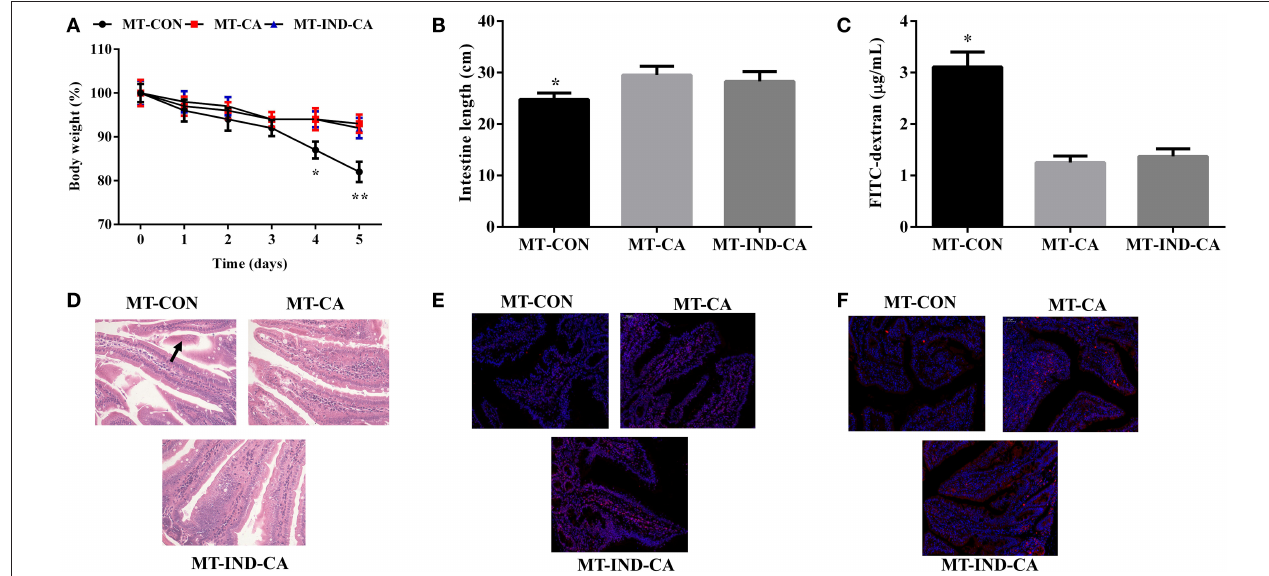
FIGURE 6 | CGA-originated microbiota prevented intestinal morphology damage and barrier dysfunction caused by indomethacin. (A) Body weight changes after the mice were gavaged with indomethacin; (B) intestinal length; (C) Concentration of FITC-dextran in serum; (D) HE staining of colon morphology (200 × ), The morphology changes were marked with black arrows; Occludin (E) and claudin-1 (F) expression in colon by immunofluorescence assay (Red, tight junction proteins; Blue, DAPI). Values are expressed as mean ± SEM, n = 4. * P < 0.05; ** P <